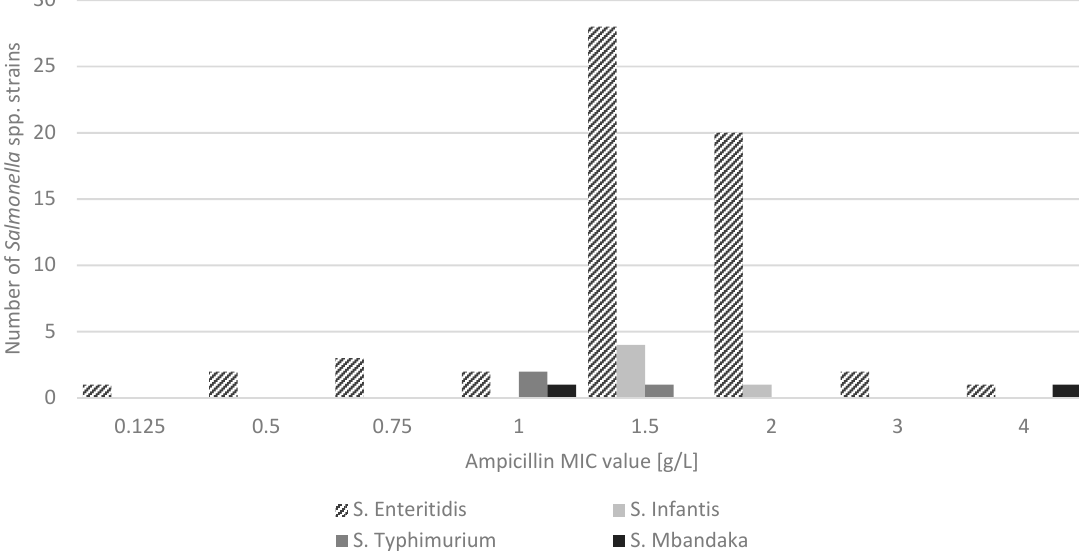
Figure 3. Ampicillin MIC values for S. enterica strains ( n = 69).